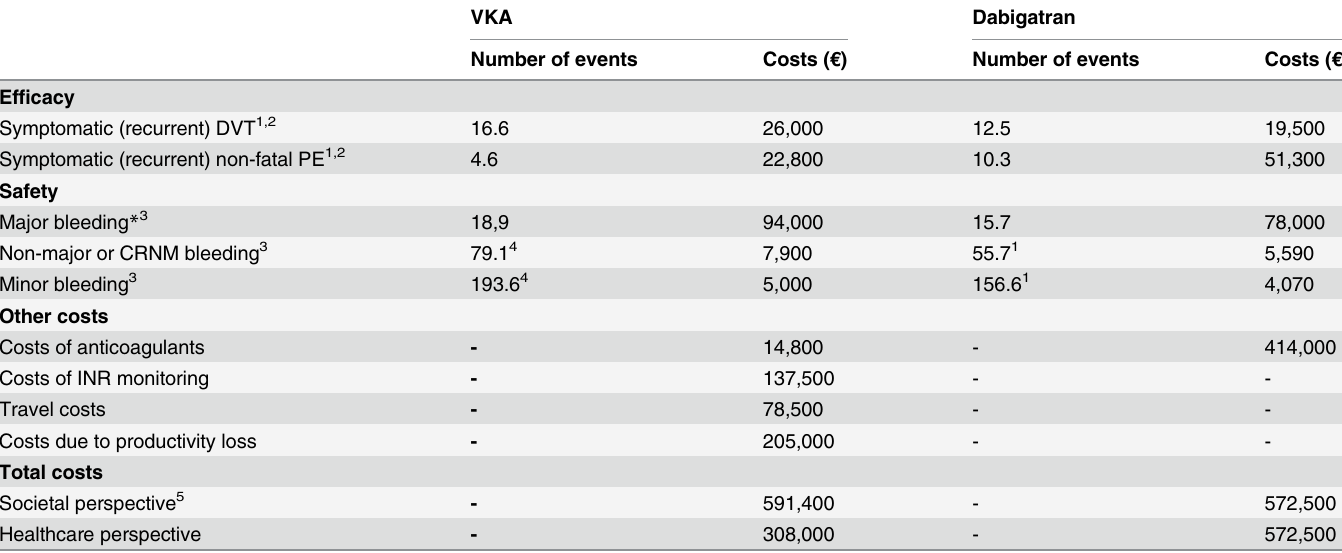
Table 2. Events and costs ( € , 2013).